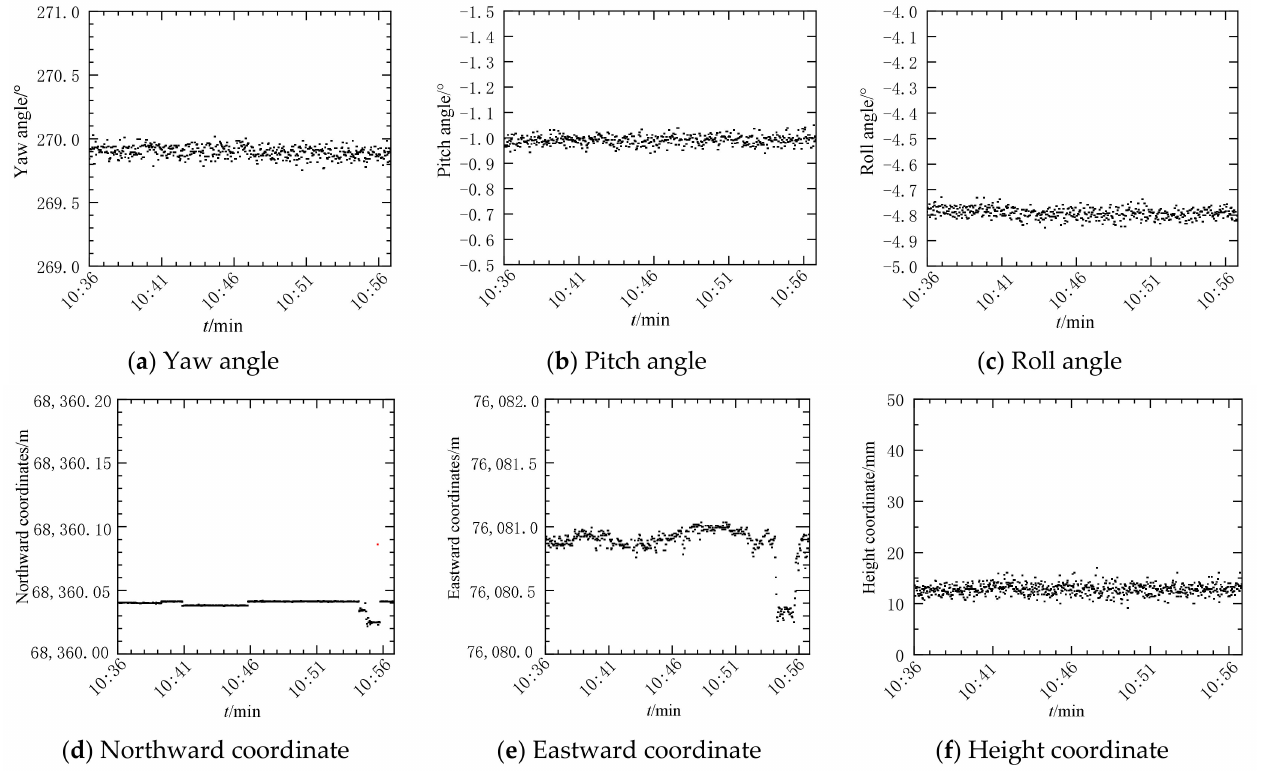
Figure 17. Pose parameter monitoring